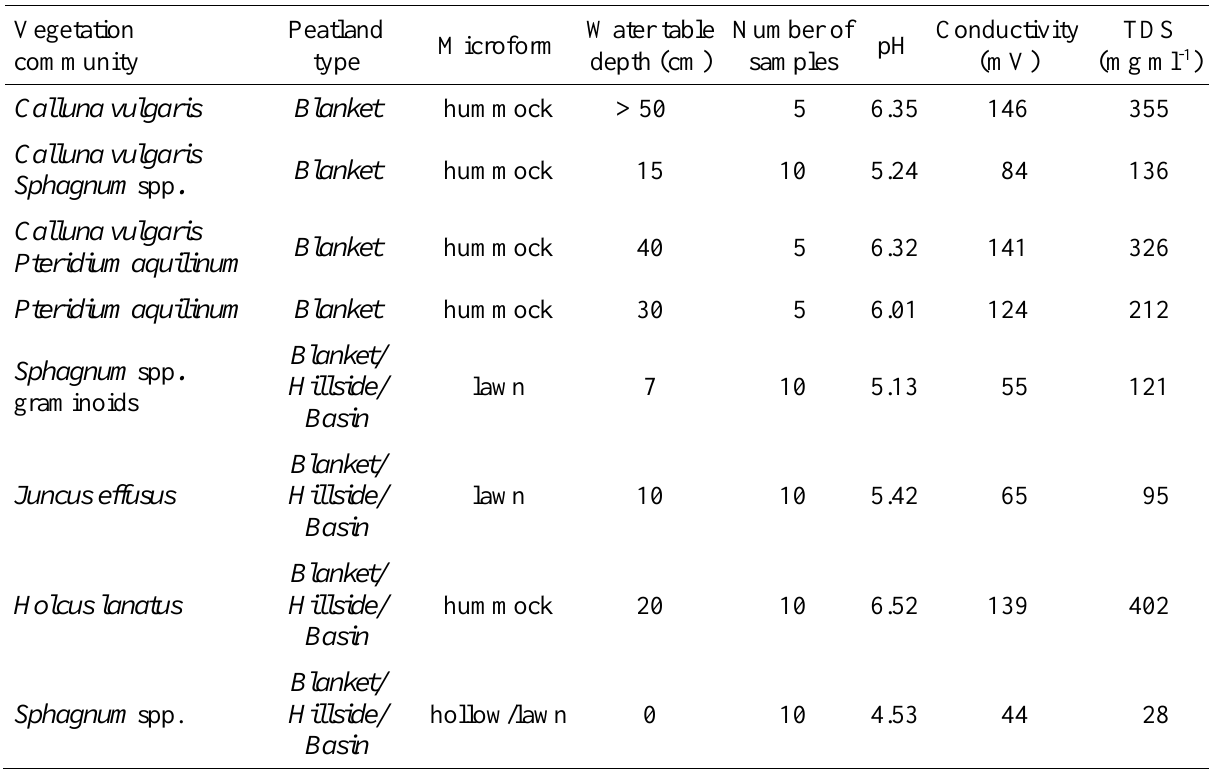
Figure 5. Watersheds, flowlines and flow direction in the Criação do Filipe peatland complex and surrounding catchment area, derived using Arc Hydro Tools in ArcGis 10.1.6. Table 3. Average water table depth in each vegetation type identified in Criação do Filipe peatland complex. Parameters measured using a portable WTW pH meter, presenting average values. The dominant microrelief of each vegetation type marked and recorded the types of peatland where each vegetation is present. Information collected in November